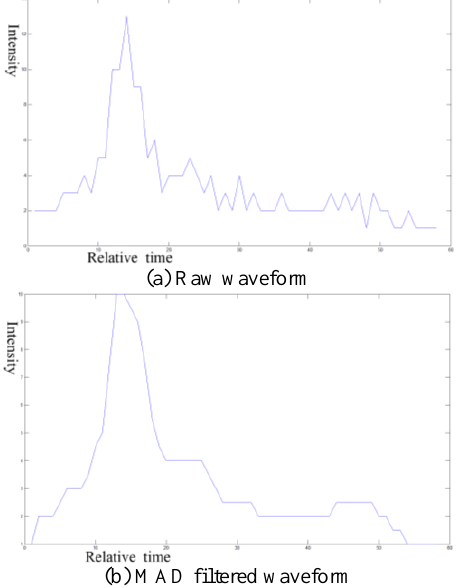
Figure 1. Raw waveform and the filtered